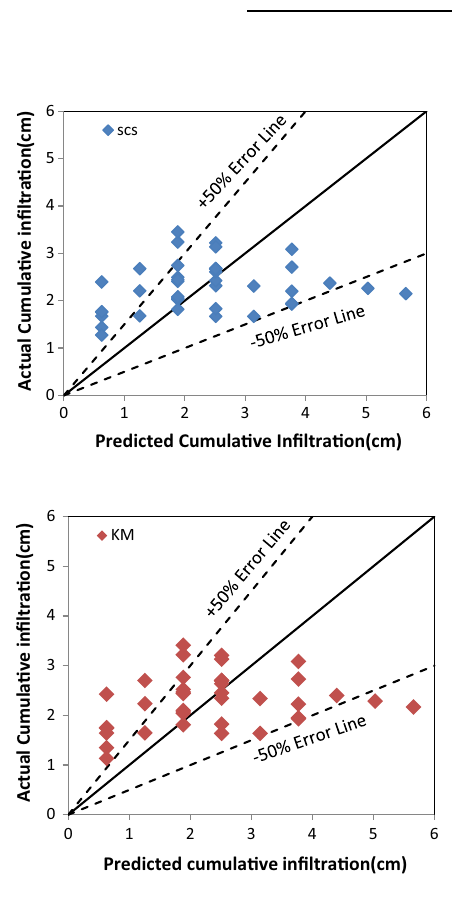
Table 6 Performance evaluation parameters of training and testing dataset of conventional models